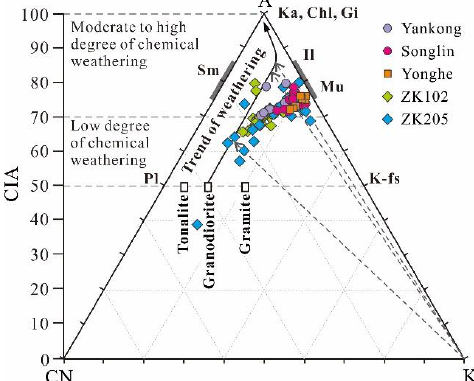
Figure 6. A-CN-K ternary diagram showing the diagenetic K-metasomatism of the Early Cambrian black shales. The associated range of the CIA values is also indicated. A — Al 2 O 3 ; CN — CaO* + Na 2 O; K — K 2 O; CIA — chemical index of alteration; Ka - kaolinite; Chl — chlorite; Gi — gibbsite;